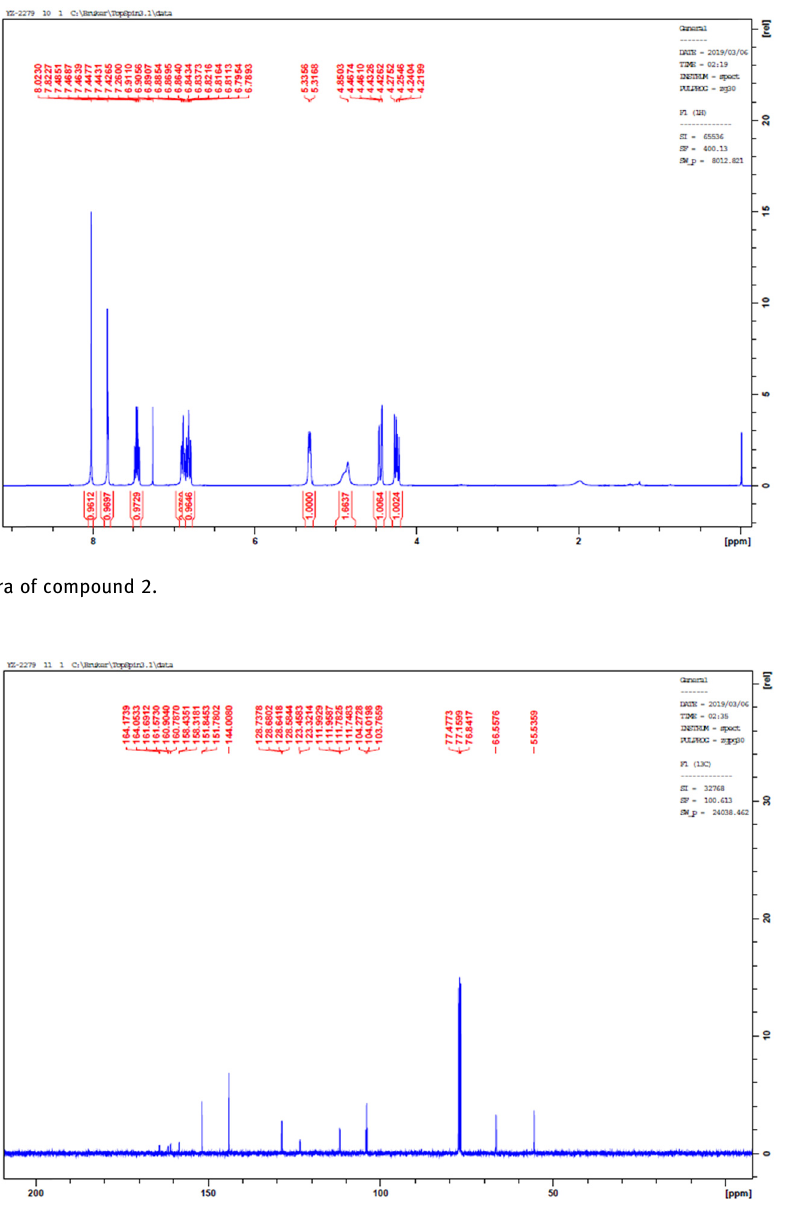
Figure A2: 13 C NMR spectra of compound